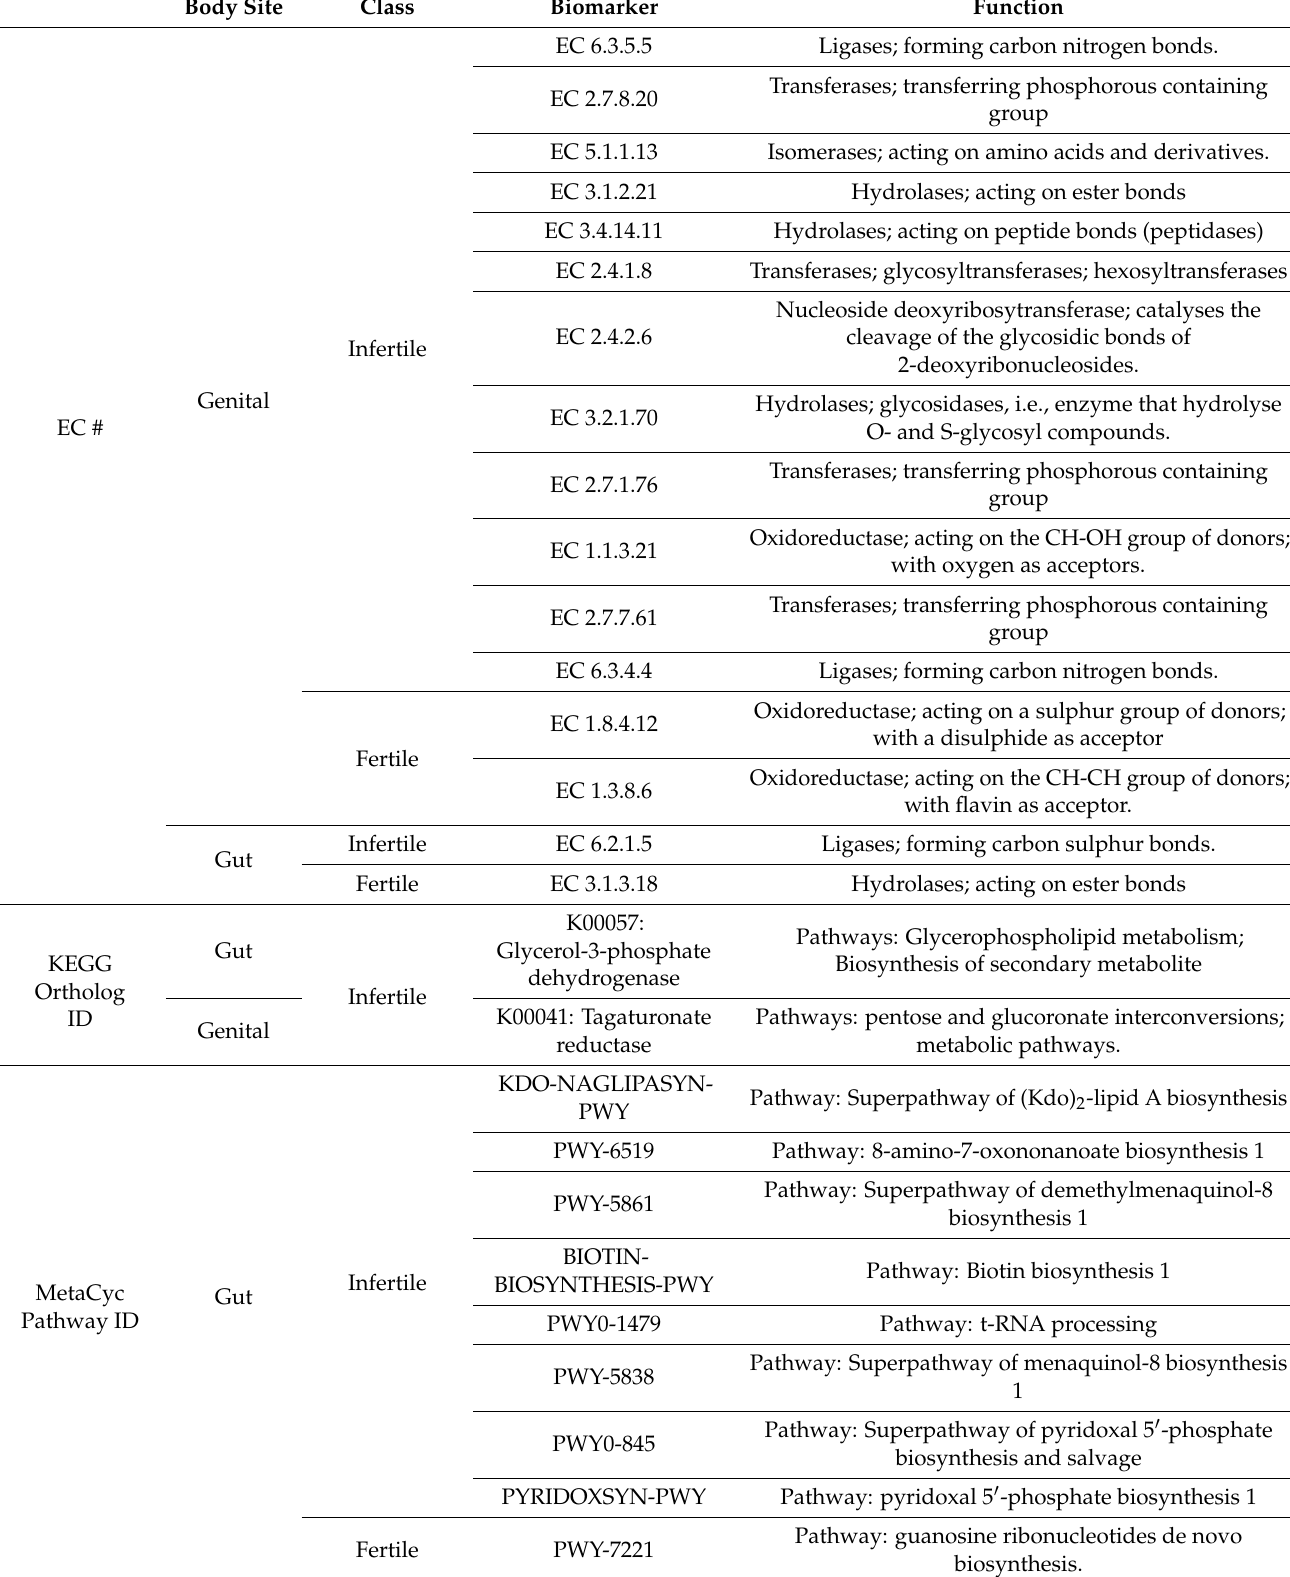
Table 11. Differentially abundant metagenome features in gut and genital